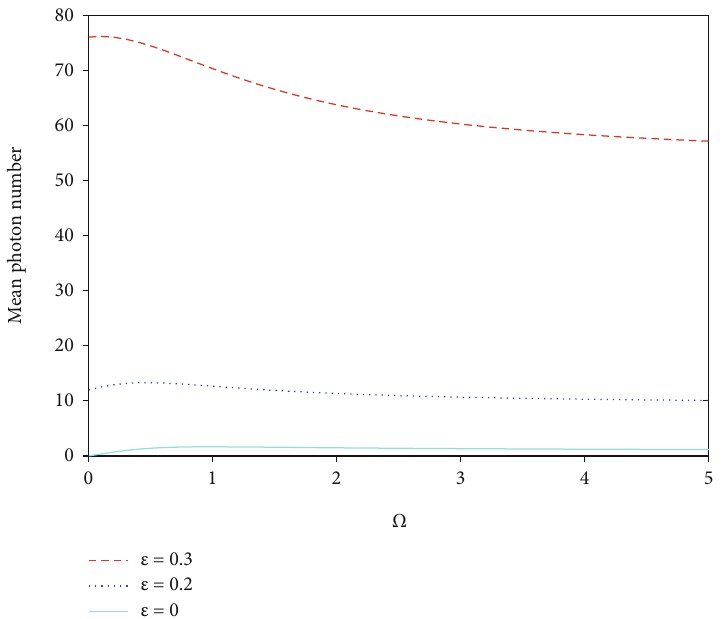
Figure 5: Plots of the steady-state mean photon number versus Ω , for γ